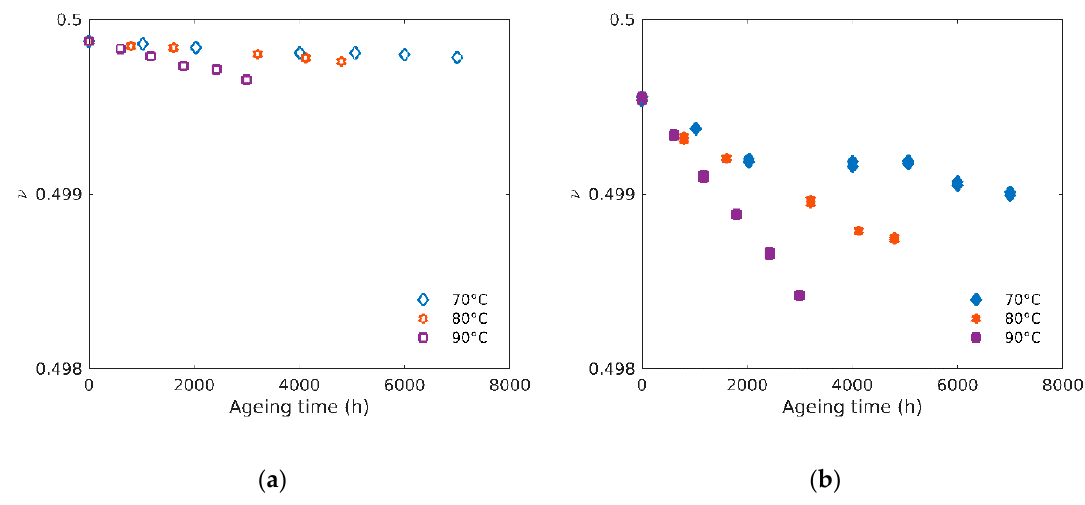
Figure 11. ( a ) Poisson’s ratio versus ageing time for unfilled and ( b ) filled rubbers at 70°C, 80°C and